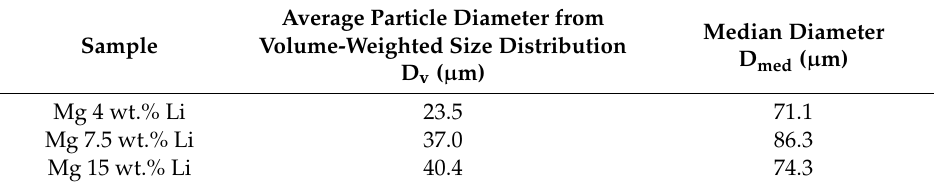
Table 1. The particle size for powders with various lithium contents.